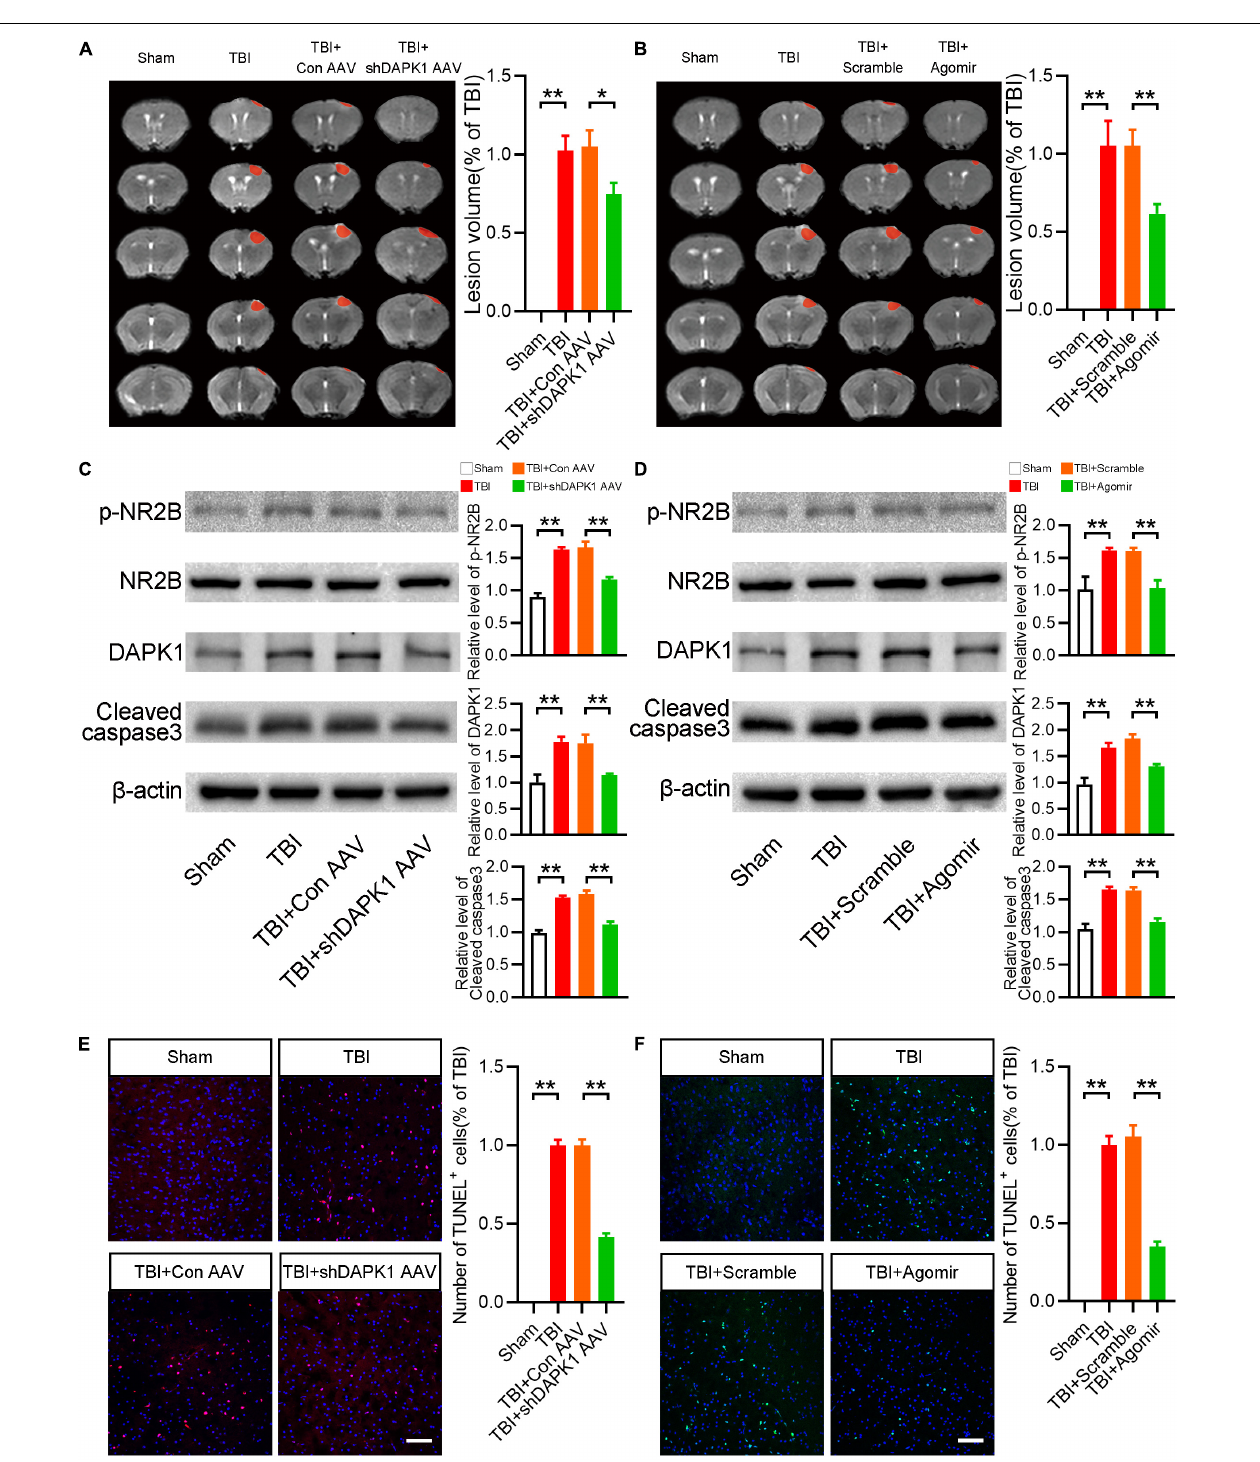
FIGURE 4 | Overexpression of miR-124 or knockdown DAPK1 reduced apoptosis and the expression level of phosphorylated NR2B. (A) Representative MRI and statistical analysis of lesion volume after AAV-shDAPK1 or AAV-Con injection. (B) Representative MRI and statistical analysis of lesion volume after agomir or scramble injection. (C) Western blotting analysis of the expression levels of p-NR2B/NR2B, DAPK1 and cleaved caspase3 after AAV-shDAPK1 or AAV-Con injection. (D) Western blotting analysis of the expression levels of p-NR2B/NR2B, DAPK1 and cleaved caspase3 after agomir or scramble injection. (E) Representative TUNEL staining images and quantitative analyses of TUNEL + cells after AAV-shDAPK1 or AAV-Con injection. (F) Representative TUNEL staining images and quantitative analyses of TUNEL + cells after agomir or scramble injection. n = 6 for each group; ** p < 0.01, * p < 0.05; Values are presented as the mean ± SEM.